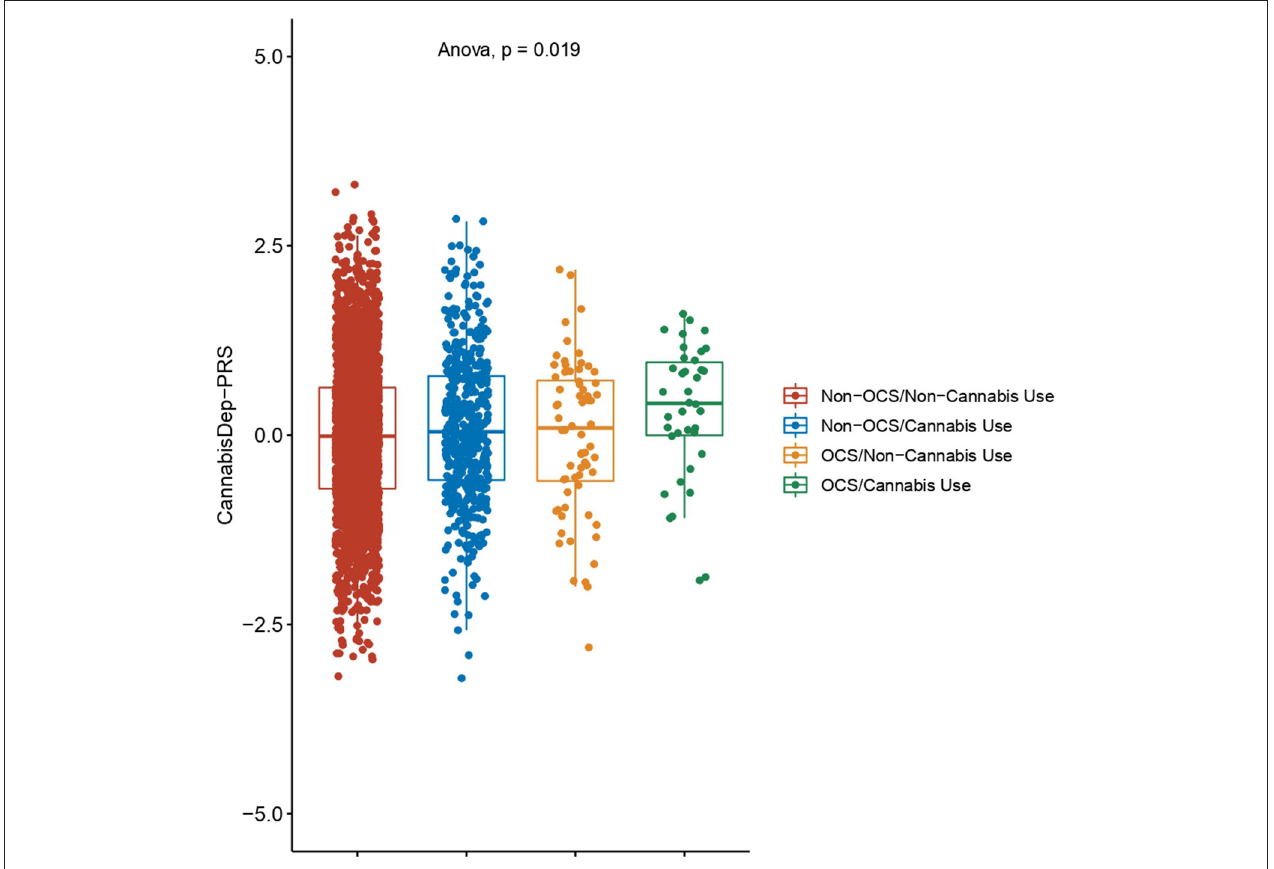
FIGURE 3 | Polygenic risk score for cannabis dependence (CannabisDep-PRS). The CannabisDep-PRS was calculated with data reported from the Psychiatric Genomics Consortium and standardized by ancestry. Differences between the four groups were evaluated by ANOVA. Non-OCS: individuals without OCS symptoms; Non-Cannabis Use: individuals who had never used cannabis; OCS: individuals with OCS symptoms; and Cannabis Use: individuals who had ever used cannabis.